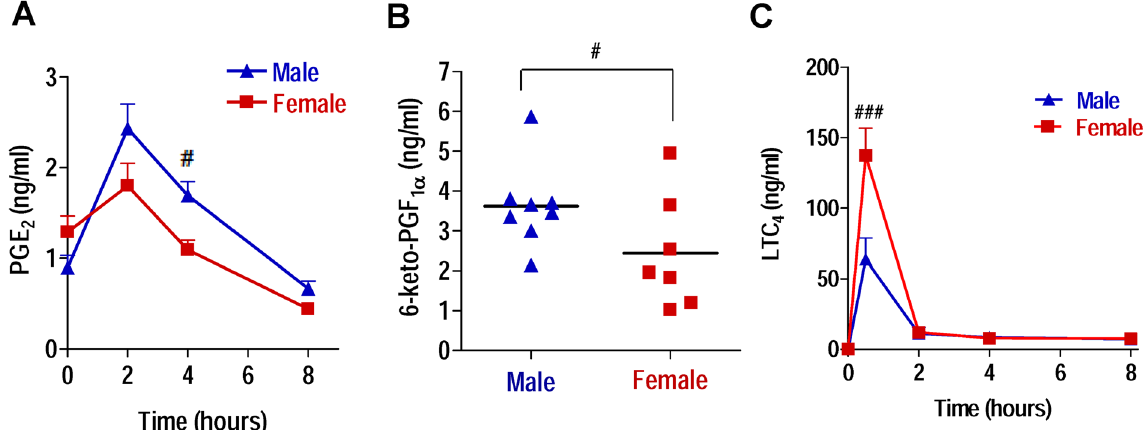
Figure 1. PGE 2 , 6-keto-PGF 1 α and LTC 4 peritoneal levels in male and female mice after zymosan-induced peritonitis. Mice were treated with zymosan ( i . p .), sacrificed at the indicated time points and ( A ) PGE 2 and ( C ) LTC 4 were measured in peritoneal exudates from male and female mice, and ( B ) 6-keto-PGF 1 α was measured in peritoneal exudates 4 hrs after zymosan injection. Time zero (T0) corresponded to untreated mice. Values represent means ± S.E.M; n = 10 mice/T0; n = 10 mice/2 hrs; n = 10 mice/4 hrs; n = 6 mice/8 hrs. ### p < 0.001 and # p < 0.05, male vs female mice; two-way ANOVA plus Bonferroni ( A and C ) and two-tailed Student’s t test ( B